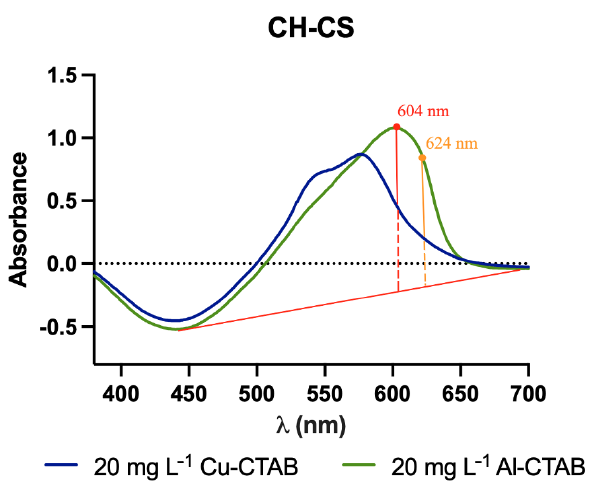
Figure 12. Absorption spectra of CS membranes on immersion in CTAB-supplemented solutions of Al(III) and Cu(II) at 20 mg L −1 concentration — comparison between the signals read at 605 nm and 624 nm.